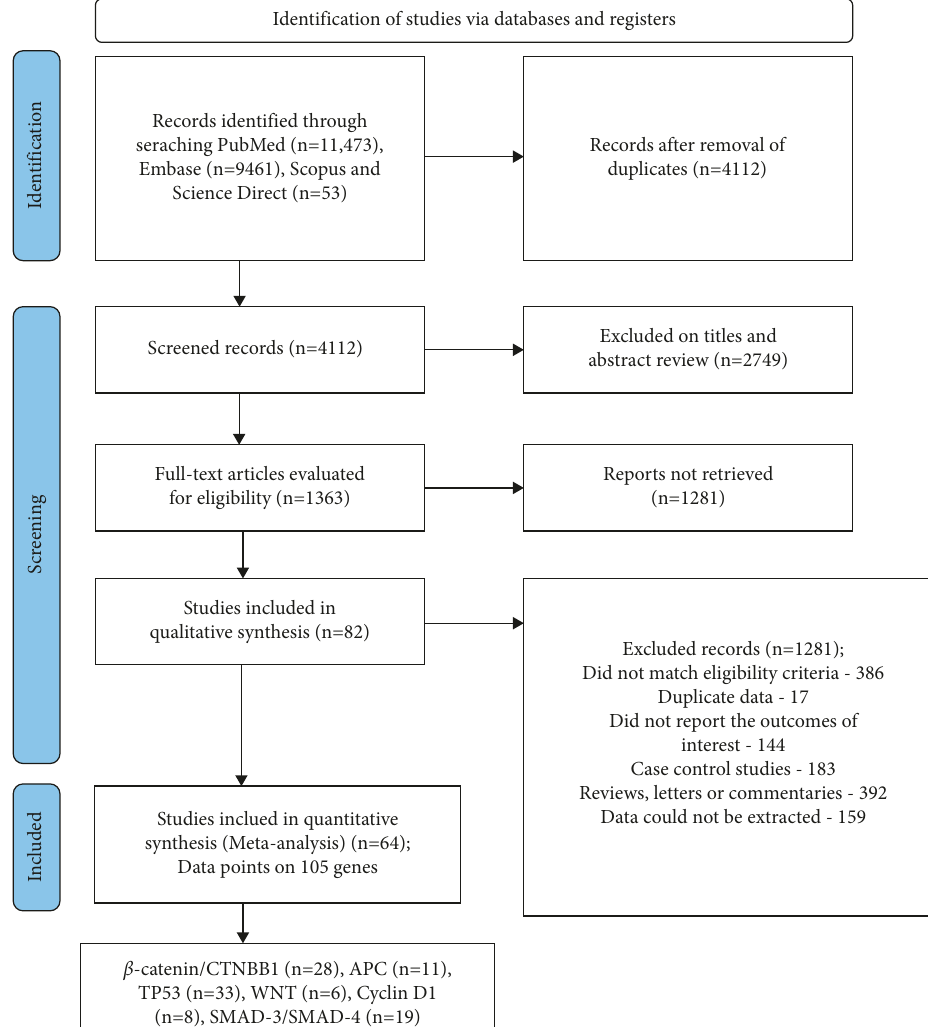
Figure 1: PRISMA flow chart of the selected